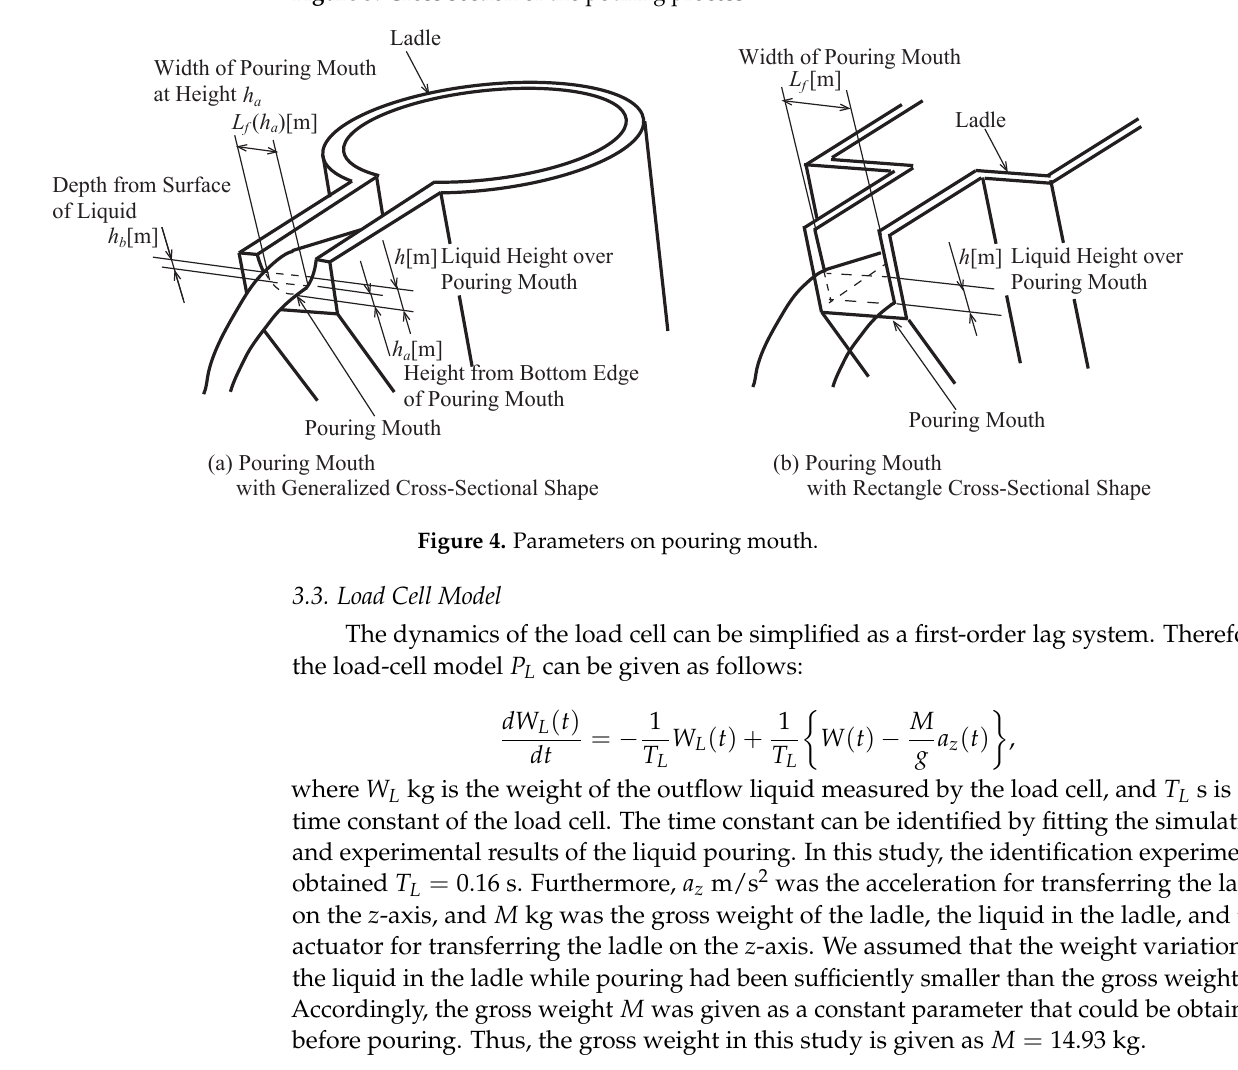
Figure 3. Cross section of the pouring process.